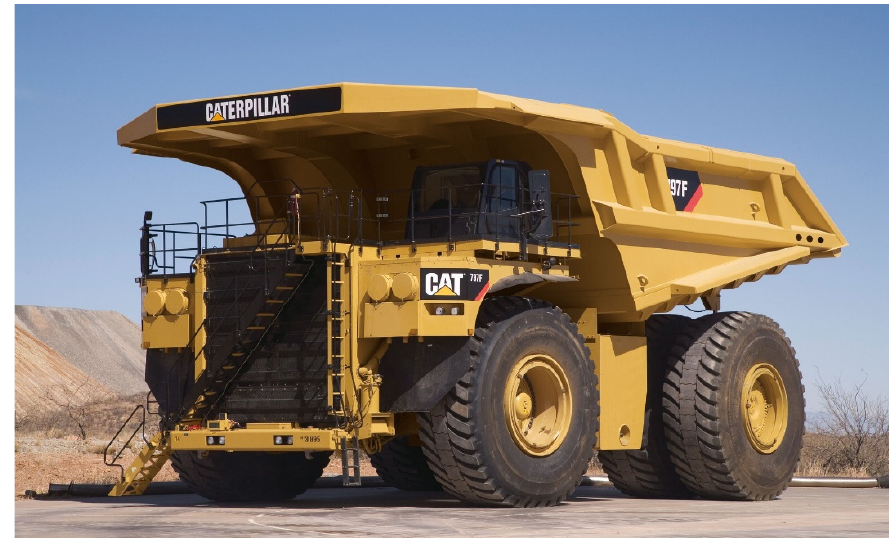
Figure 6. Off-highway